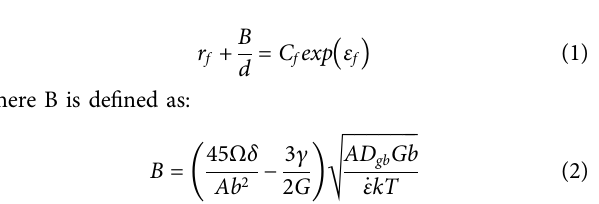
FIGURE 3 | Total elongation against inverse grain size for several superplastic materials. + Ti-6Al-4V deformed at 1200 K and 2.0 × 10 − 4 s − 1 ; Ternarybrassdeformedat874 Kand1.67 × 10 − 4 s − 1 ;7475Alalloydeformed at 789 K and 3.0 × 10 − 4 s − 1 ; × Al-Mg-Scalloy deformed at698 K and 3.0 × 10 − 2 s − 1 ; × Al-14Ni-14Mn alloy deformed at 873 K and 1.0 s − 1 ; (cid:129) ZrO- dispersed Al deformed at 1727 K and 1.7 × 10 − 4 s − 1 (Liu and Ma, 2011).